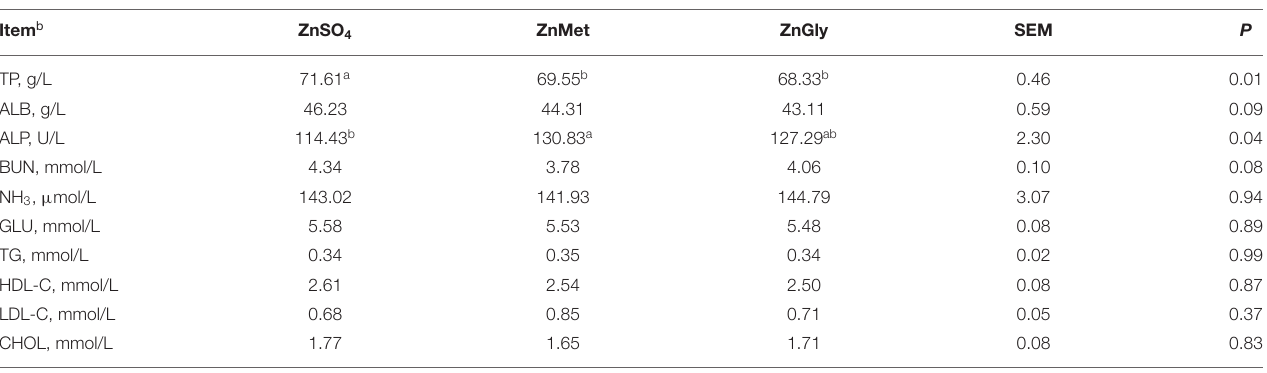
TABLE 4 | Serum metabolites of finishing pigs fed Zn diets a